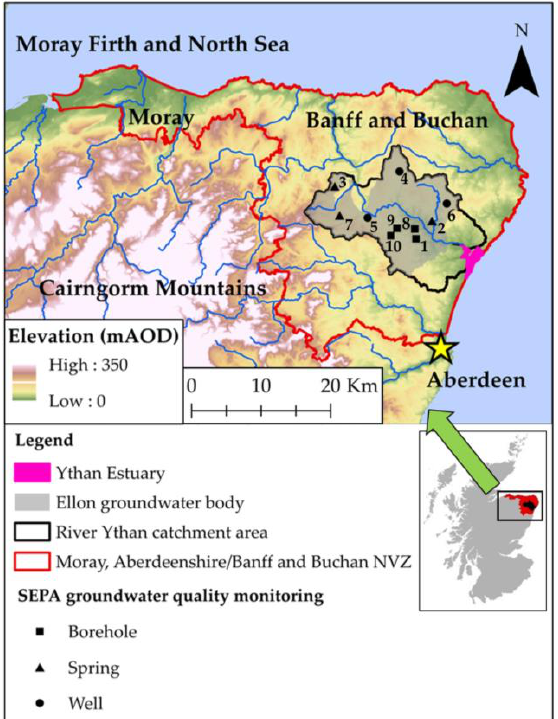
Figure 1. Map of the River Ythan catchment area and Ellon groundwater body in relation to the wider Moray, Aberdeenshire/Banff and Buchan Nitrate Vulnerable Zone (NVZ). SEPA groundwater quality monitoring stations are labelled 1–10. Sources: Scottish Government 2015; SEPA 2023; Contains Ordnance Survey data © Crown copyright and database right, 2023.